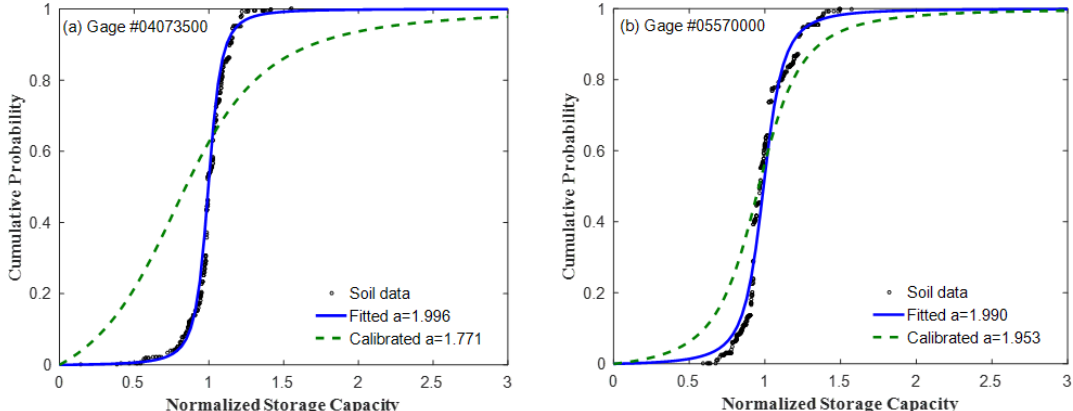
Figure 5. The estimated shape parameter for the spatial distribution of soil water storage capacity based on soil data and the calibrated shape parameter based on mean annual water balance in the Fox River watershed (a) and the Spoon River watershed (b)